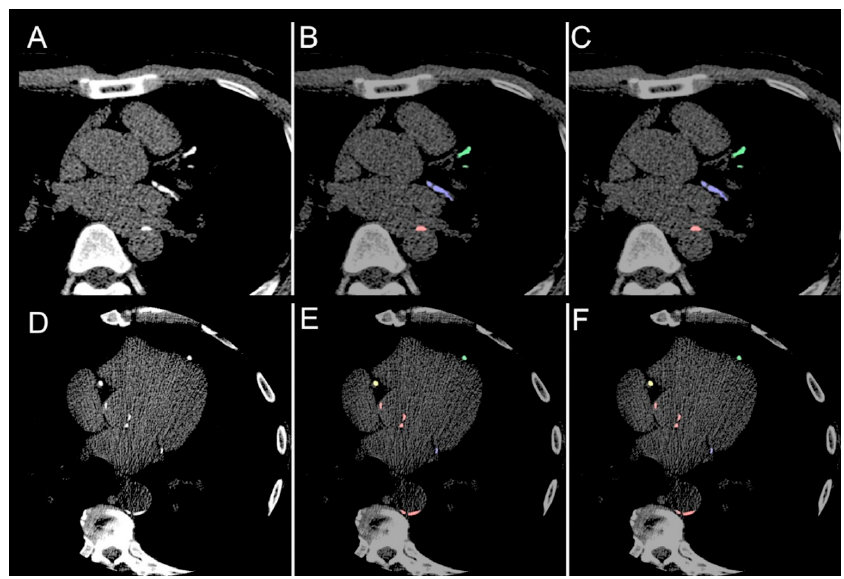
Figure 4. Comparison. ( A , D ) Illustrative comparisons between original image; ( B , E ) manual annota- tion ground truth; ( C , F ) the model predicted segmentation mask. The model is able to identify both calcifications of the left anterior descending (green), left circumflex (blue) and right coronary arteries (yellow) as well as aortic calcium (red). Linear regression plots for the ranking of predictions against ranking of ground truth are shown (Figure 5). There was good correlation and agreement for CAC prediction (rho = 0.876, p < 0.001), with a difference of 11.2% ( p = 0.100). AC correlated well (rho = 0.947, p Table 2. Model < 0.001), with a mean difference of 9% ( p = 0.070). Examples of disagreement between ground truth and model predictions are shown in Figure 6.